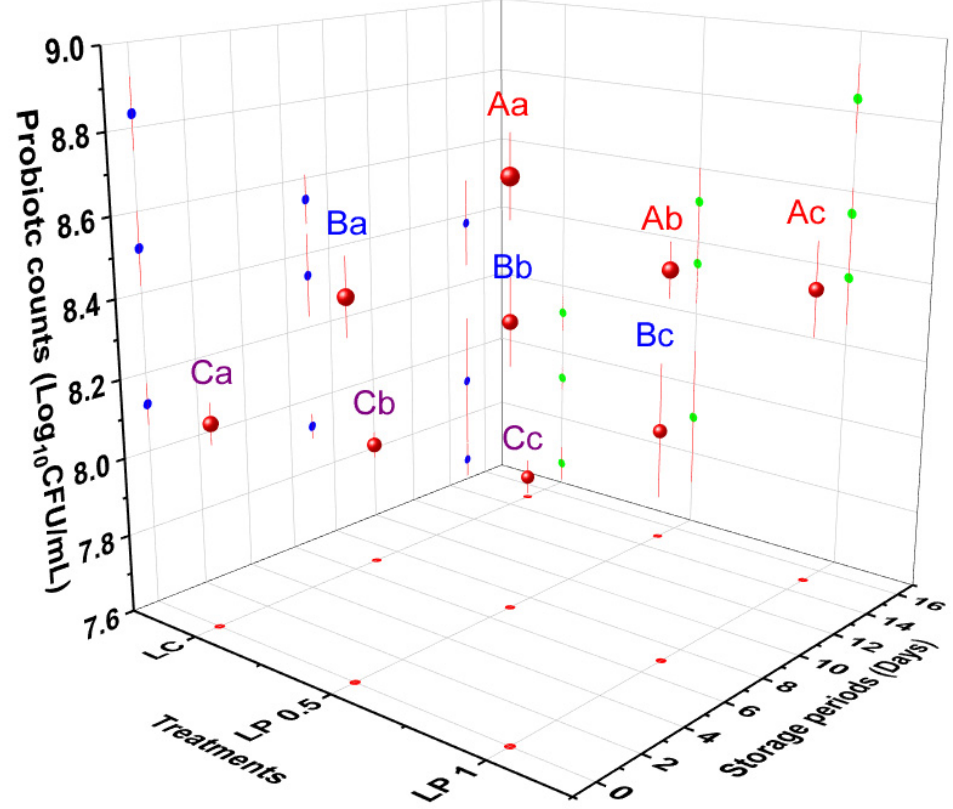
Figure 2. Counts of EcN in labneh during refrigerated storage. LC (labneh without PFPP), LP 0.5 (labneh with 0.5% of PFPP and LP 1 (labneh with 1% of PFPP). Different uppercase superscripts indicate significant ( p < 0.05) differences between the values for various concentrations of PFPP incorporation. Different lowercase superscripts indicate significant ( p < 0.05) differences between the values during the shelf ‐ life of labneh. Vertical bars show the standard division of the treatment means.